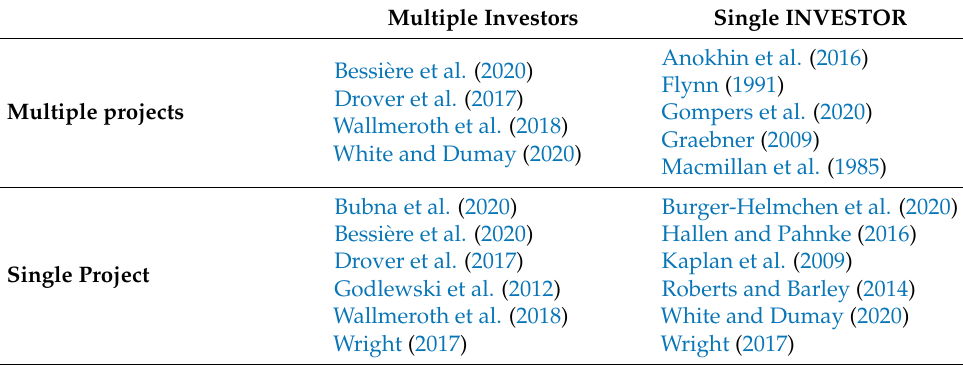
Table 1. Typology of investing cases and related articles. Source: